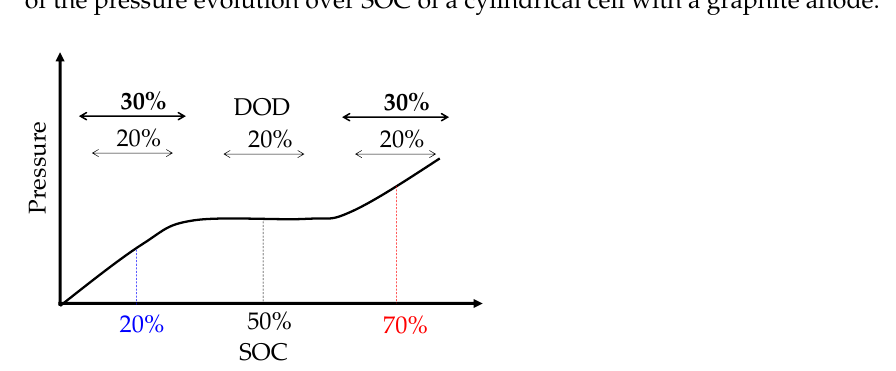
Figure 1. Check-up routine.